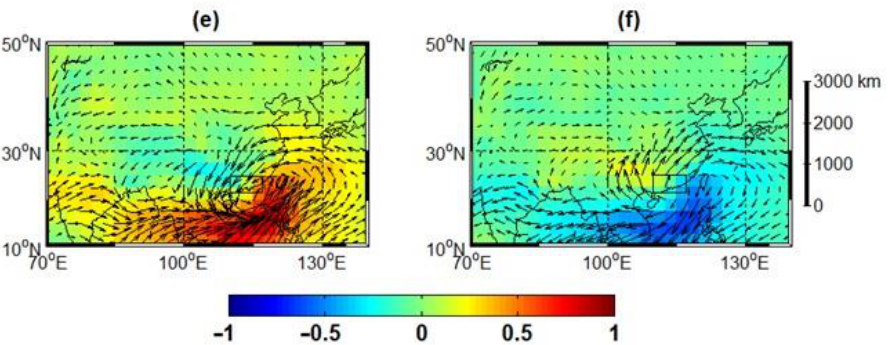
Figure 5. Results of clustering of IVT standardized anomalies using k-means method in ( a , b ) North China (NC), ( c , d ) Yangtze River Valley (YRV), and ( e , f ) South China (SC) for JJA 1980–2019. Type 1 ( left column) represents AR days. Type 2 ( right column) represents non-AR days.